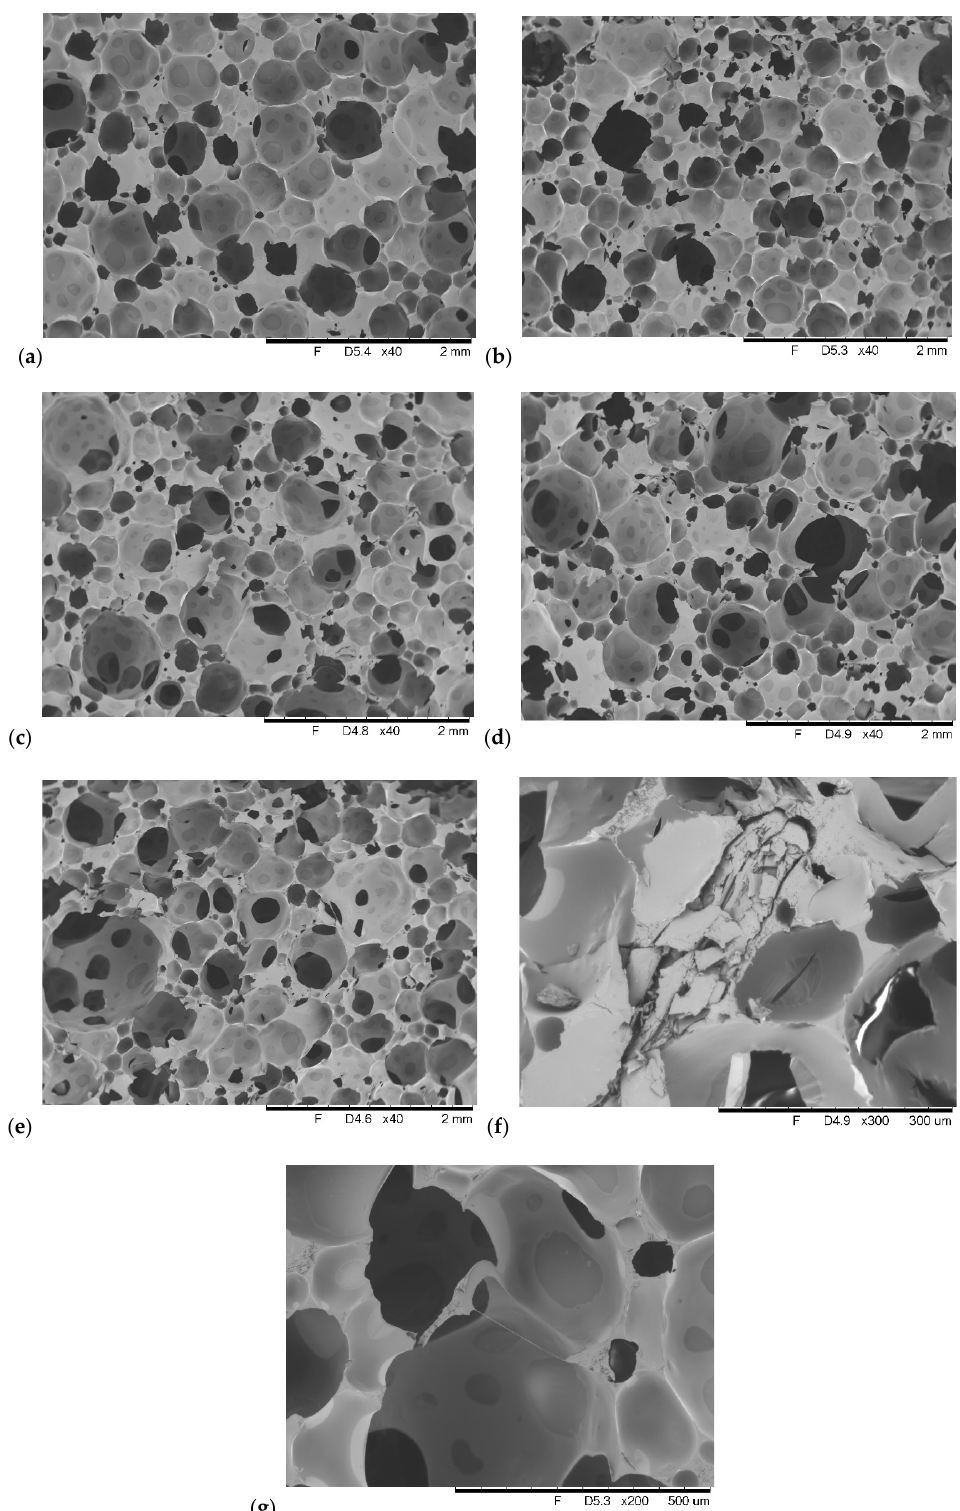
Figure 8. SEM images of selected foams: ( a ) R - reference foam, ( b ) R+10K - reference foam with addition of 10% keratin, ( c ) R+10K+5F - reference foam with addition of 10% keratin and 5% Fyrol, ( d ) R+10K+10GE - reference foam with addition of 10% keratin and 10% Expanding graphite, ( e ) R+10K+10GE+5F - reference foam with addition of 10% keratin, 10% Expanding graphite and 5% Fyrol, ( f ) R+10K+10GE+5F - GE in foam, ( g ) R+10K- keratin fiber in foam. The introduction of keratin fibers causes a significant change in the pore size of the foams. In the samples R+10K (Figure 8b) and R+10K+5F (Figure 8c), the appearance of a larger number of pores with smaller sizes was observed compared to the sample R (Figure 8a). In Figure 8b,c no differences due to Fyrol incorporation were observed. The incorporation of GE into the R+10K foam (Figure 8b) causes the R+10K+10GE foam (Figure 8d) to produce more large-sized pores. A similar change was observed after the introduction of GE into the R+10K+5F foam (Figure 8c), more large-sized pores are formed in the R+10K+10GE+5F foam Figure 8e). The observation of the GE structure in the R+10